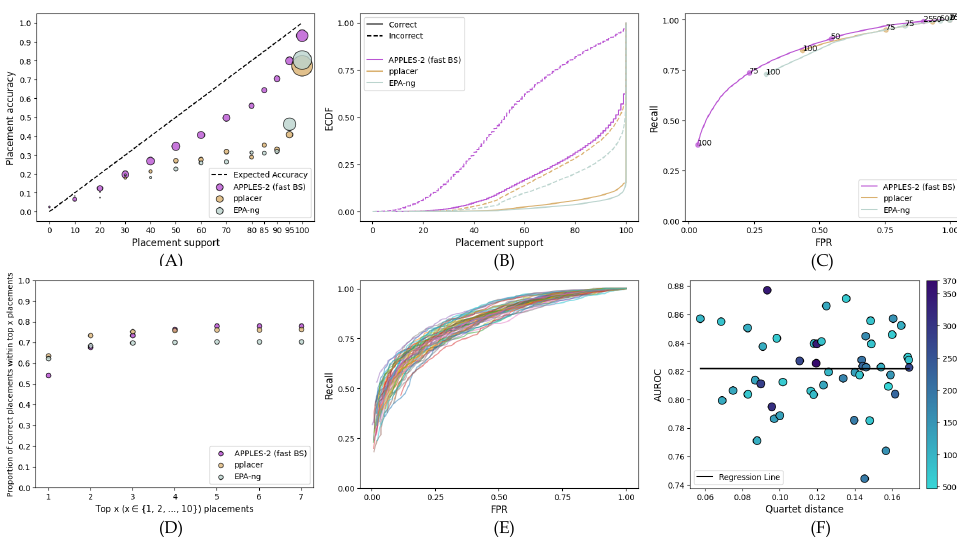
Figure 7. Results for the WOL dataset’s placement of each of the 50 best genes on the species tree . ( A ) Support vs. Accuracy, ( B ) ECDF, ( C ) ROC curves. ( D ) Frequency of correct placements within the top 1 ≤ x ≤ 10 highest support placements. ( E ) Individual ROC curves for all 50 genes, along with the ROC curve of the concatenation of 50 genes. ( F ) Quartet distance of the gene trees to the species tree versus AUROC. We colored the data points with a color gradient that varies continuously from light blue to dark blue, which corresponds to increasing gene